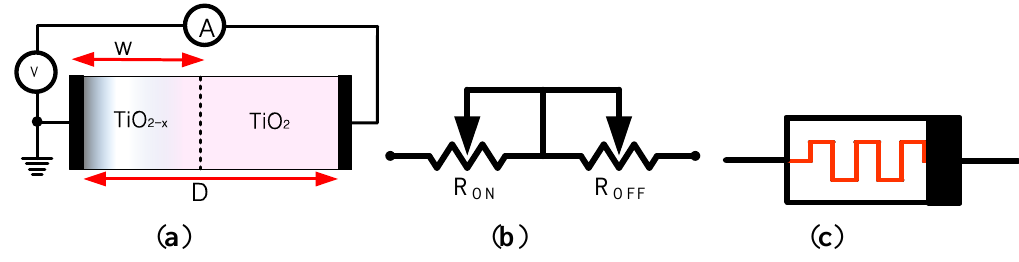
and TiO layers are sandwiched 2−x 2